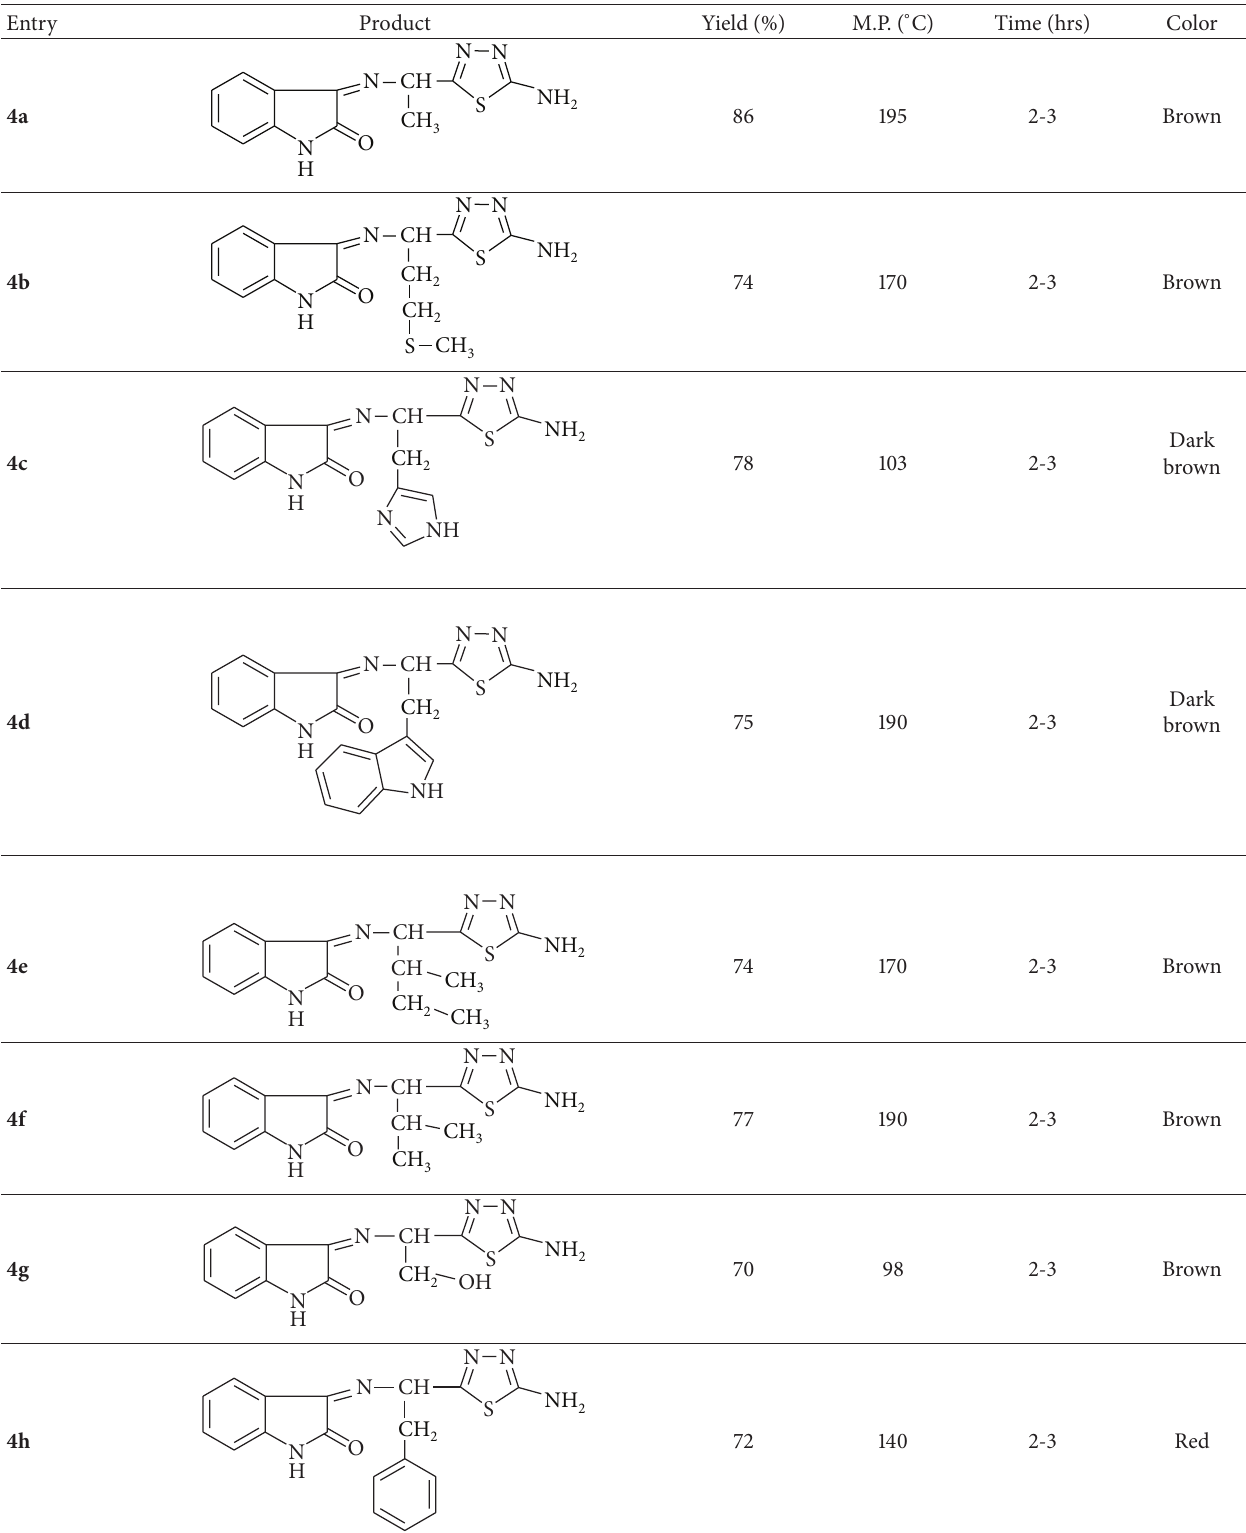
Table 1: Results of synthesis of 4a – p in the presence of lemon juice as natural